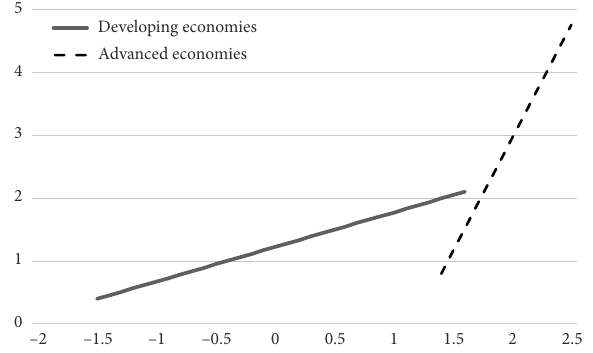
Figure 4. Marginal effects of the output gap on total surplus conditional on government effectiveness, significant at 95%